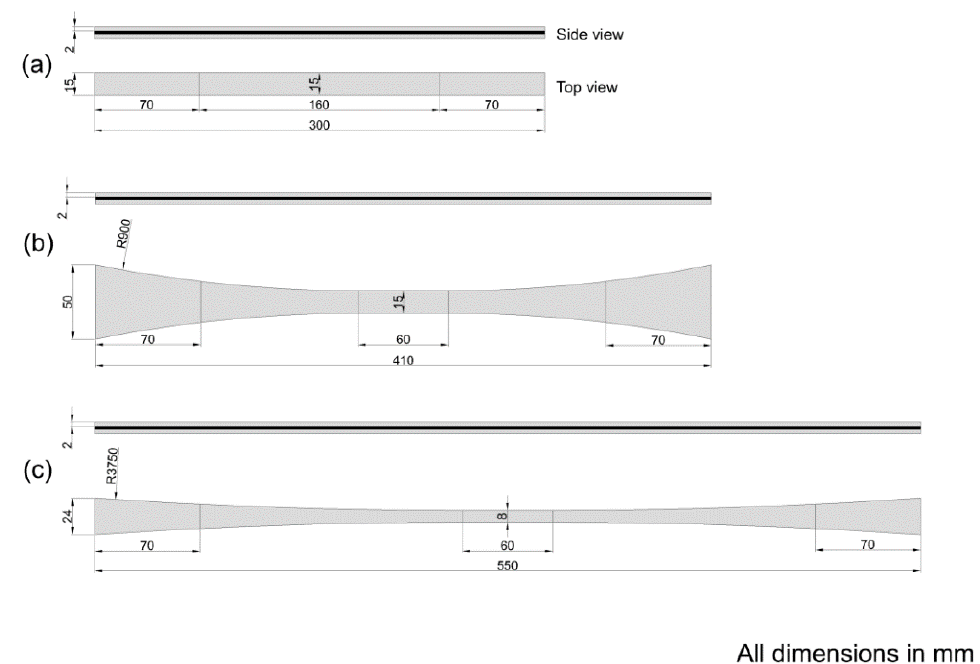
Figure 2. Protected test specimens; geometry and dimensions: ( a ) straight-sided, ( b ) butterfly, ( c ) X- butterfly.